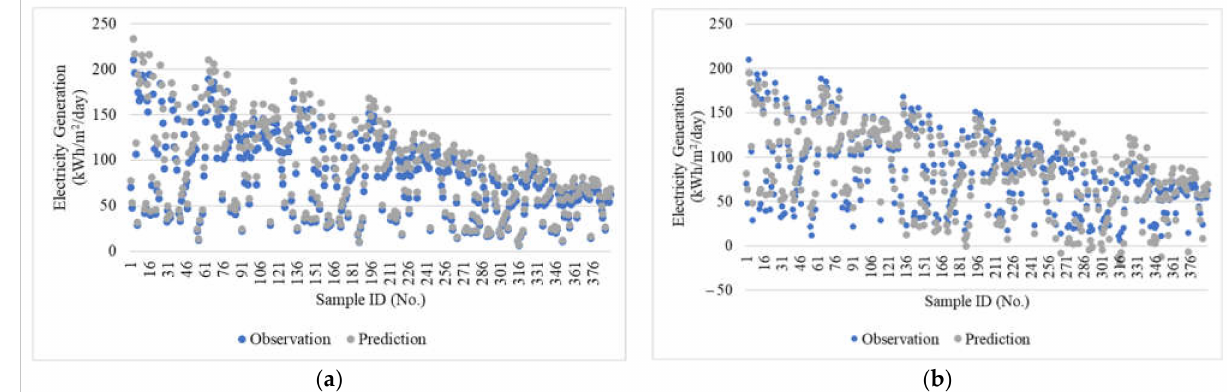
Figure 4. Prediction results: ( a ) climate-based model; ( b ) polynomial regression